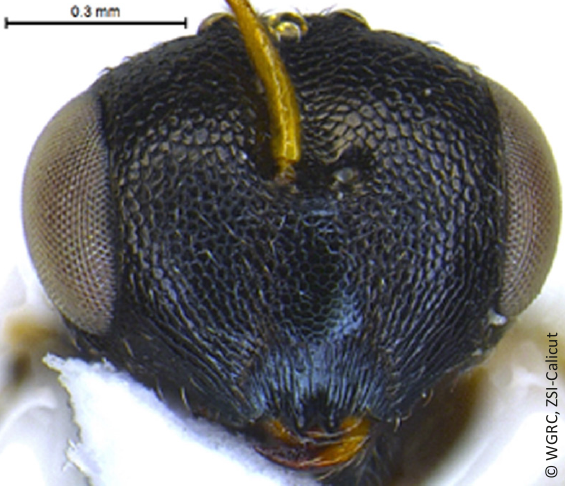
Image 7. Psilocera keralensis sp. nov. Male head in front